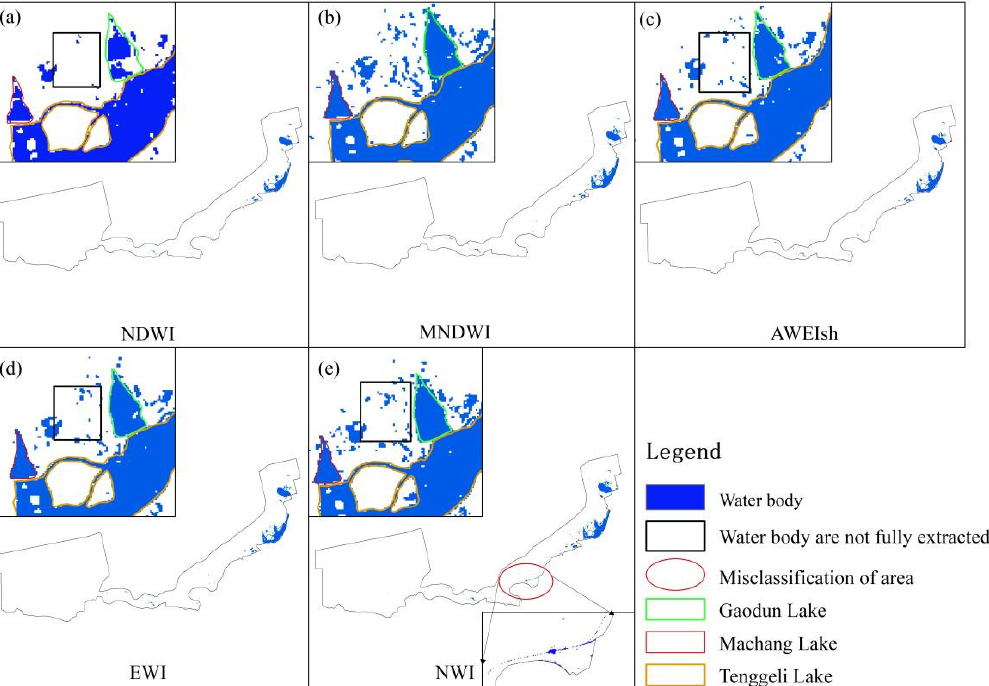
Figure 7. Extraction of images for effects. ( a ) NDWI extraction result, ( b ) MNDWI extraction result, ( c ) EWI extraction result, ( d ) AWEIsh extraction result, ( e ) NWI extraction result.